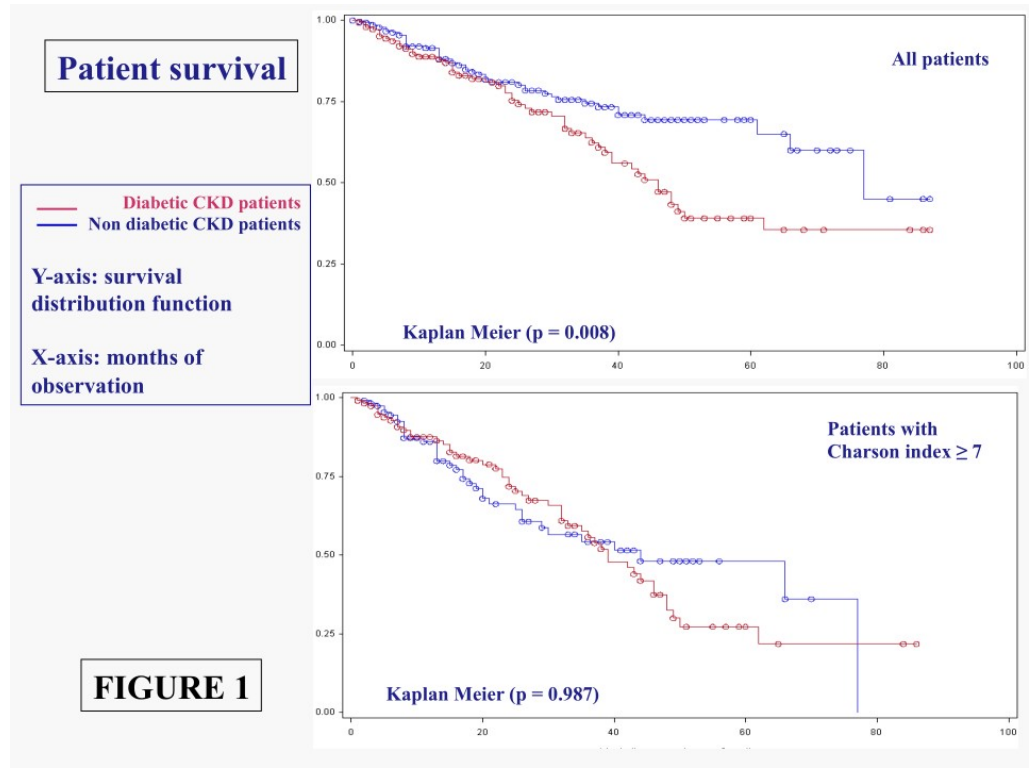
Figure 1. Patient survival in diabetic and non ‐ diabetic CKD patients: All cases and patients with Charlson index ≥ 7.